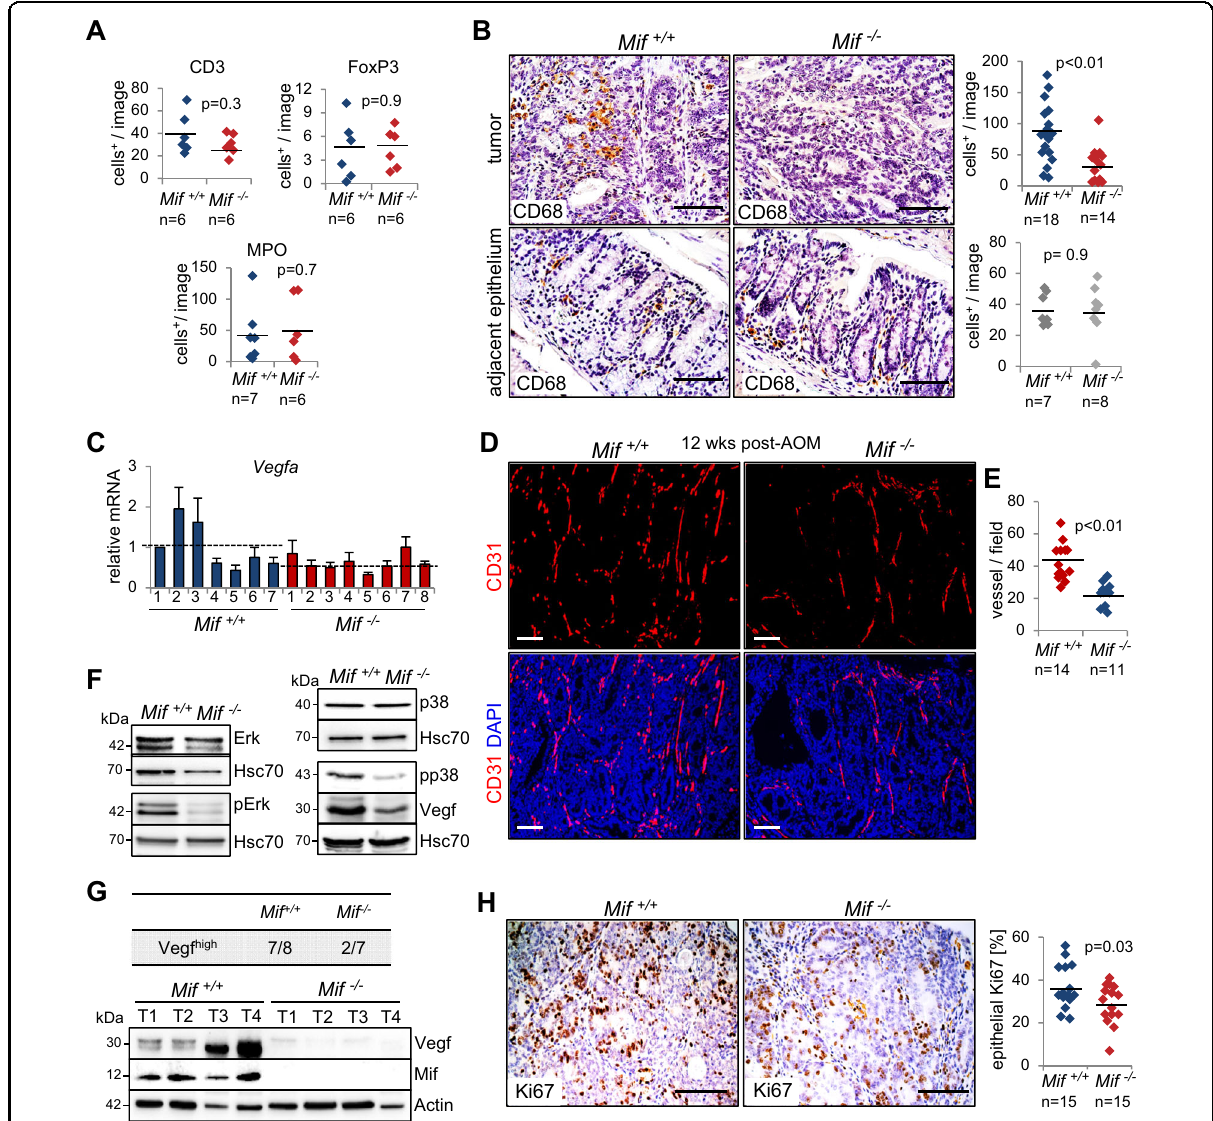
Fig. 4 MIF accelerates proliferation and angiogenesis in established colorectal tumors. A Quanti fi cation of the indicated histological staining of Mif + / + and Mif − / − tumors at 12 weeks post-AOM treatment. At least 2 images (area = ×40 magni fi cation) per tumor were viewed for positive stromal cells. n , tumor number from 3 mice each. B Representative CD68 staining of indicted tumors and their corresponding adjacent normal epithelium at 12 weeks post-AOM injection. Scale bars, 100µm. (Right) For each tumor, ≥ 3 images were taken, and positive staining was quanti fi ed. There were 18 tumors from 7 Mif + / + mice and 14 tumors from 8 Mif − / − mice. For adjacent epithelium, ≥ 5 images (area = ×40 magni fi cation) per mouse were viewed and counted for positive stromal cells. n , mouse numbers. C mRNA levels of Vegfa in single tumors of different mice ( Mif + / + , n = 7; Mif − / − n = 8), relative to housekeeping gene, Hprt1 . Means± SD of four technical replicates. Black dashed line, mean. D Representative immuno fl uorescence for CD31 in tumors from Mif + / + and Mif − / − mice at 12 weeks post-AOM. DAPI, counterstaining. Scale bars, 100µm. E Quanti fi cation of the vessel number from ( D ). Vessels from at least fi ve images (area = ×40 magni fi cation) per tumor were counted. A ‘ vessel ’ is de fi ned as one separate fragment of CD31 staining. n = number of tumors out of 5 mice each. F Immunoblot analysis of Mif + / + and Mif − / − tumors at 12 weeks post-AOM with pooled samples ( n ≥ 6 tumors per condition). Hsc70, loading control. G Summary of Mif + / + ( n = 8) and Mif − / − ( n = 7) tumors analyzed by immunoblot. (Bottom) Representative immunoblot analysis of single Mif + / + and Mif − / − tumors at 12 weeks post-AOM. Compared to a reference tumor (T1 of Mif + / + ), ‘ Vegf high ’ means higher or same protein levels than the reference tumor. Actin, loading control. H Representative histological staining for Ki67 in tumors from Mif + / + and Mif − / − mice and quanti fi cation at 12 weeks post-AOM. Scale bars, 100µm. Quanti fi cation of Ki67 staining counted within 2 – 4 images (area = ×40 magni fi cation) per tumor. n , tumor number; both groups showed 15 tumors from 5 mice. A , B , E , H Black lines, mean. p values were calculated by Student ’ s t